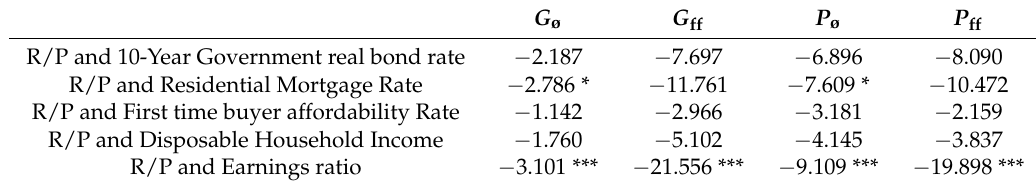
Table 2. Cointegration tests of rent to price (R/P) and various rates based on Westerlund (2007). G ø G